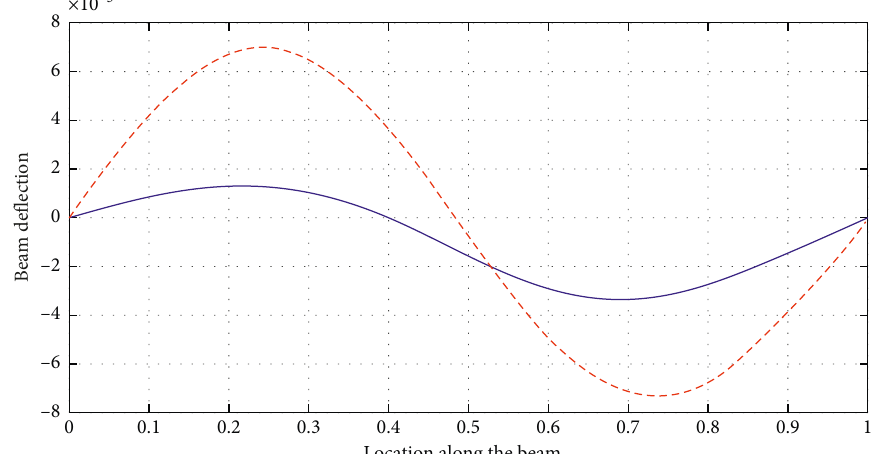
Figure 9: The steady-state deformed shape of a noncollocated controlled (solid line) and uncontrolled (dashed line) undamped simply supported beam when ω � 42, x f � 0.87, x n � 0.4, x a � 0.4, and x s � 0.75.